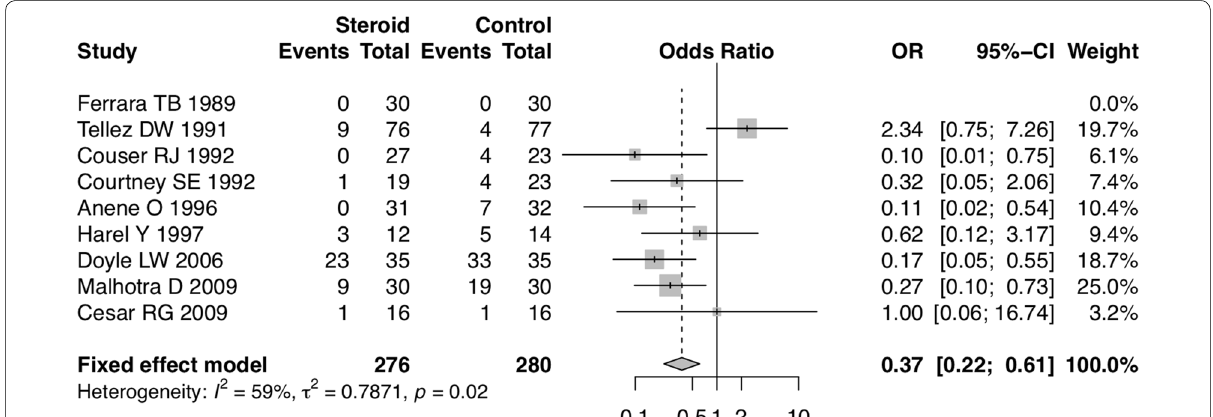
Fig. 4 Result of meta-analysis for effects of corticosteroids on incidence of extubation failure in randomized controlled trials. An odds ratio (OR) less than 1 favors corticosteroid